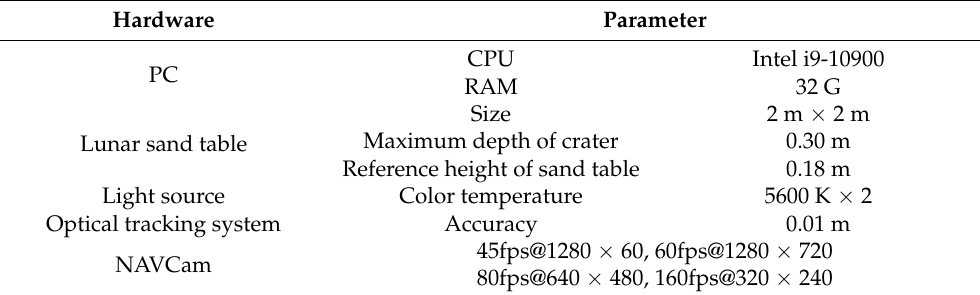
Table 4. Hardware parameters.